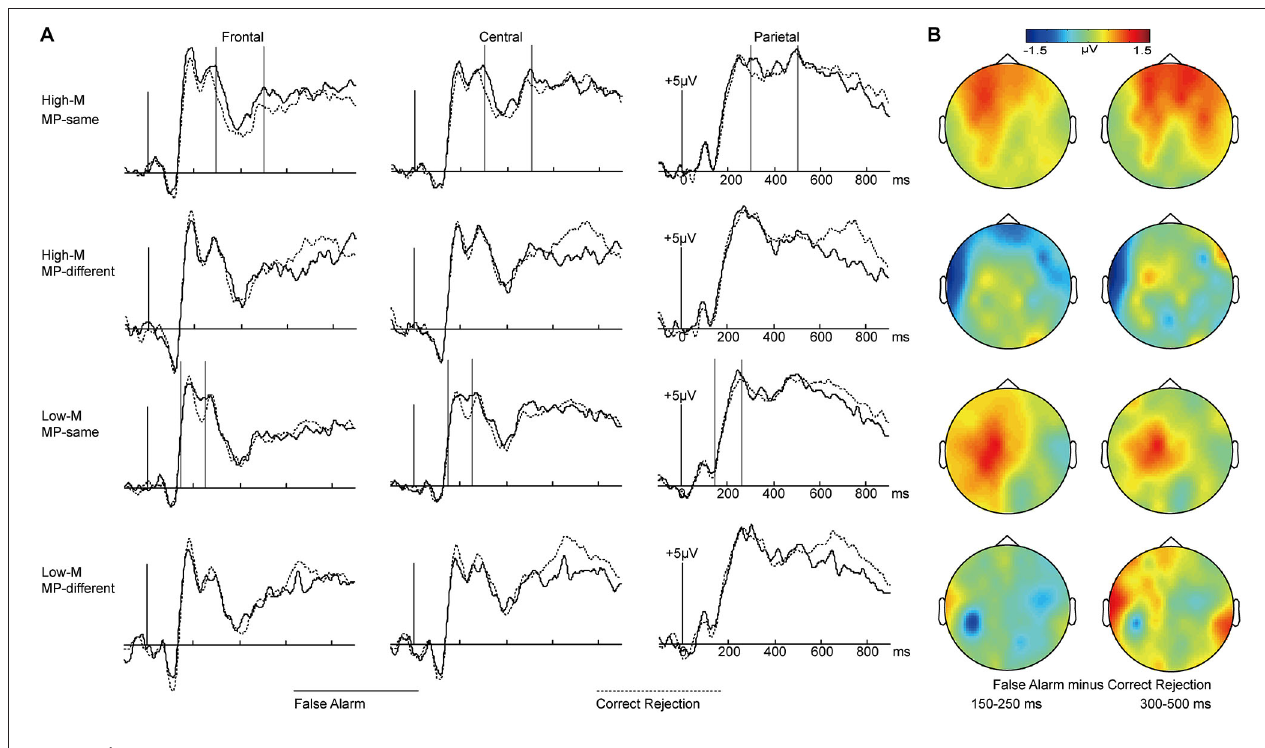
FIGURE 5 | ERPs for false alarms and correct rejections separately for MP-same and MP-different trials as a function of meaningfulness rating. (A) Waveforms are shown from midline frontal electrodes to parietal electrodes for four conditions. Gray vertical lines